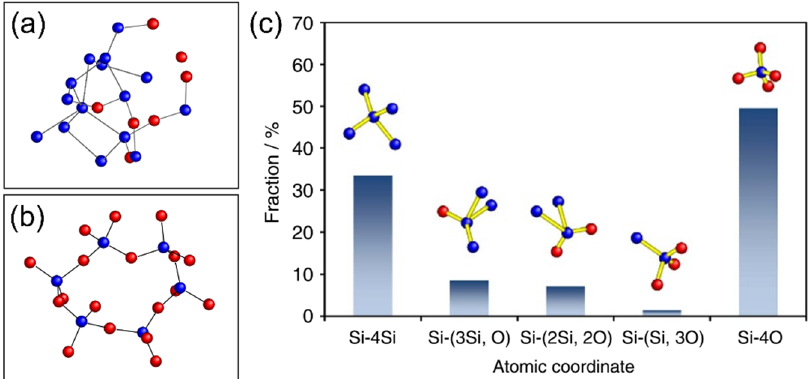
Figure 1. Atomic models of ( a ) interfacial suboxide-type tetrahedra in a-SiO and ( b ) amorphous SiO 2 in a-SiO. ( c ) Fractions of the five atomic coordinates found in a-SiO. The silicon atom is in blue, and the oxygen atom is in red. Reproduced with permission from ref. [10]. Copyright 2015, Nature Publishing Group.